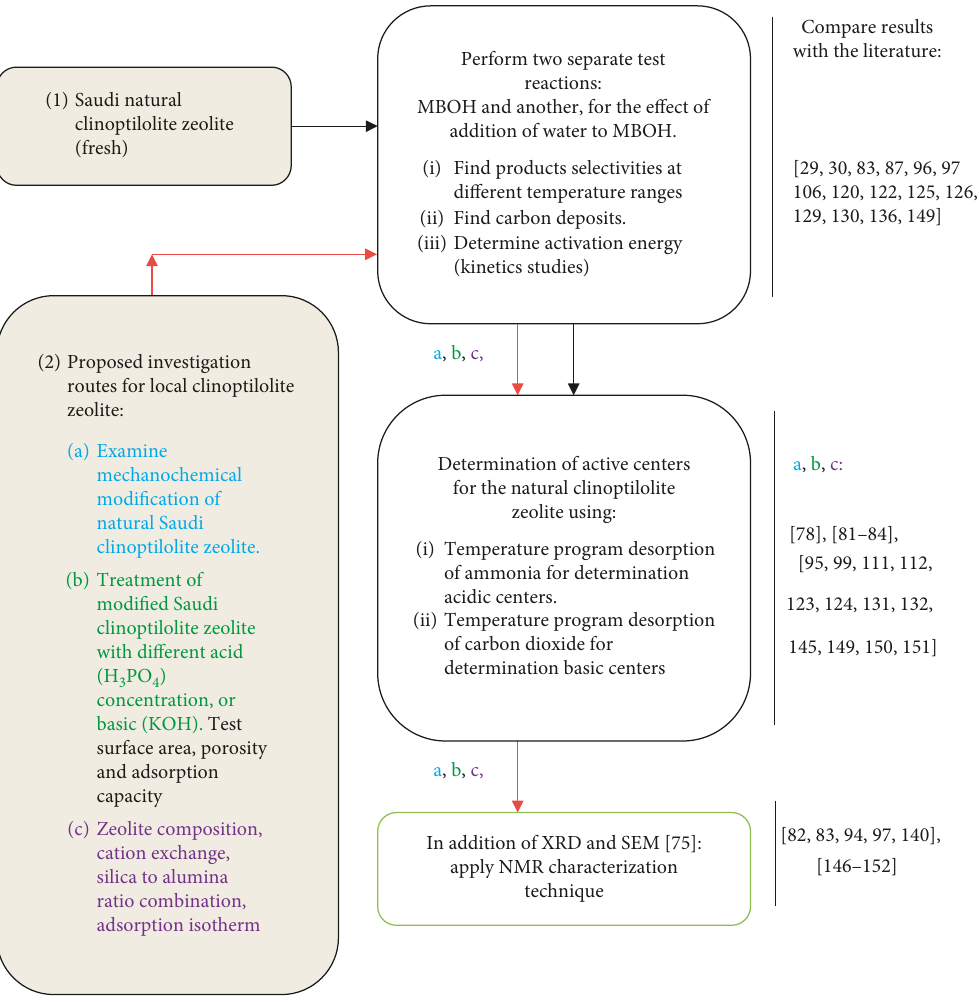
Figure 6: Proposed test protocol for modification, treatment, and characterization of natural Saudi clinoptilolite zeolite for environmental